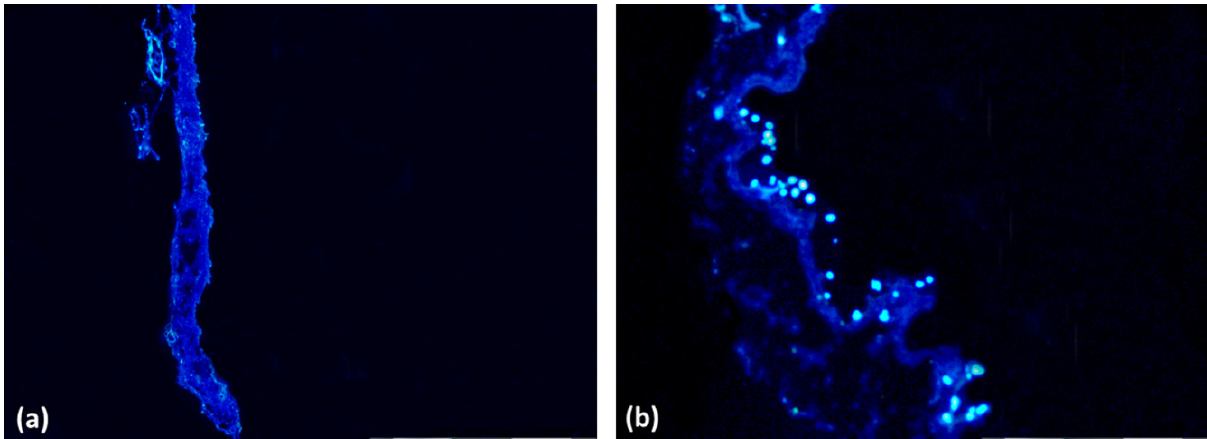
Figure 1. Immunofluorescence of bioscaffolds and nuclear labeling with DAPI. ( a ) Group 1 Bioscaffold alone (G1) without nuclei; ( b ) Group 2 Bioscaffold seeded with ASCs (G2) with nuclei labeling in blue. Magnification = 400×.